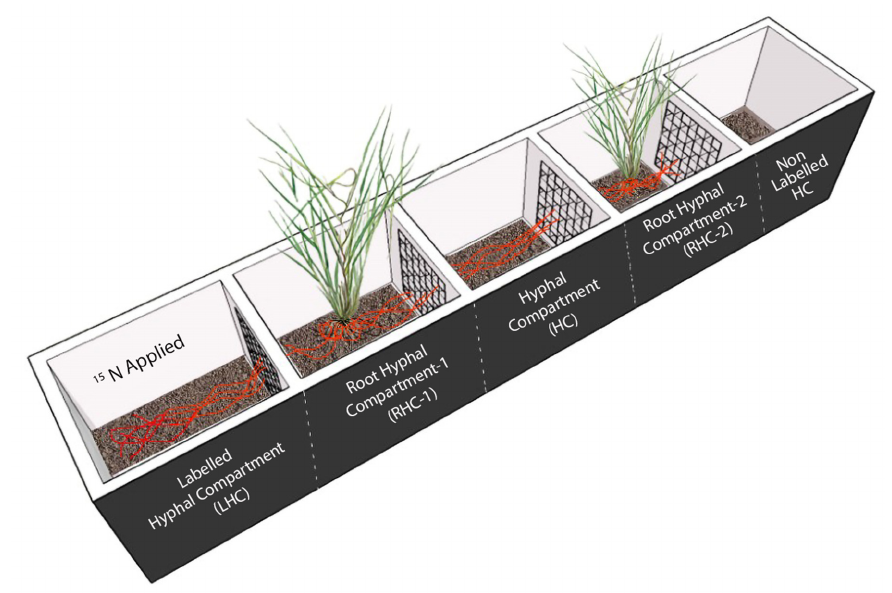
Figure 1. Schematic diagram of five-compartment root-box to grow C. squarrosa seedlings. The plant receiving AM fungal inoculum was designated as the donor plant, while the plant without inoculum was the recipient plant. The compartments were separated from each other via 37 µm mesh that only allowed the hyphae to pass, but not the roots. The black lines with the plant show the roots, while red lines show the common mycorrhizal network.